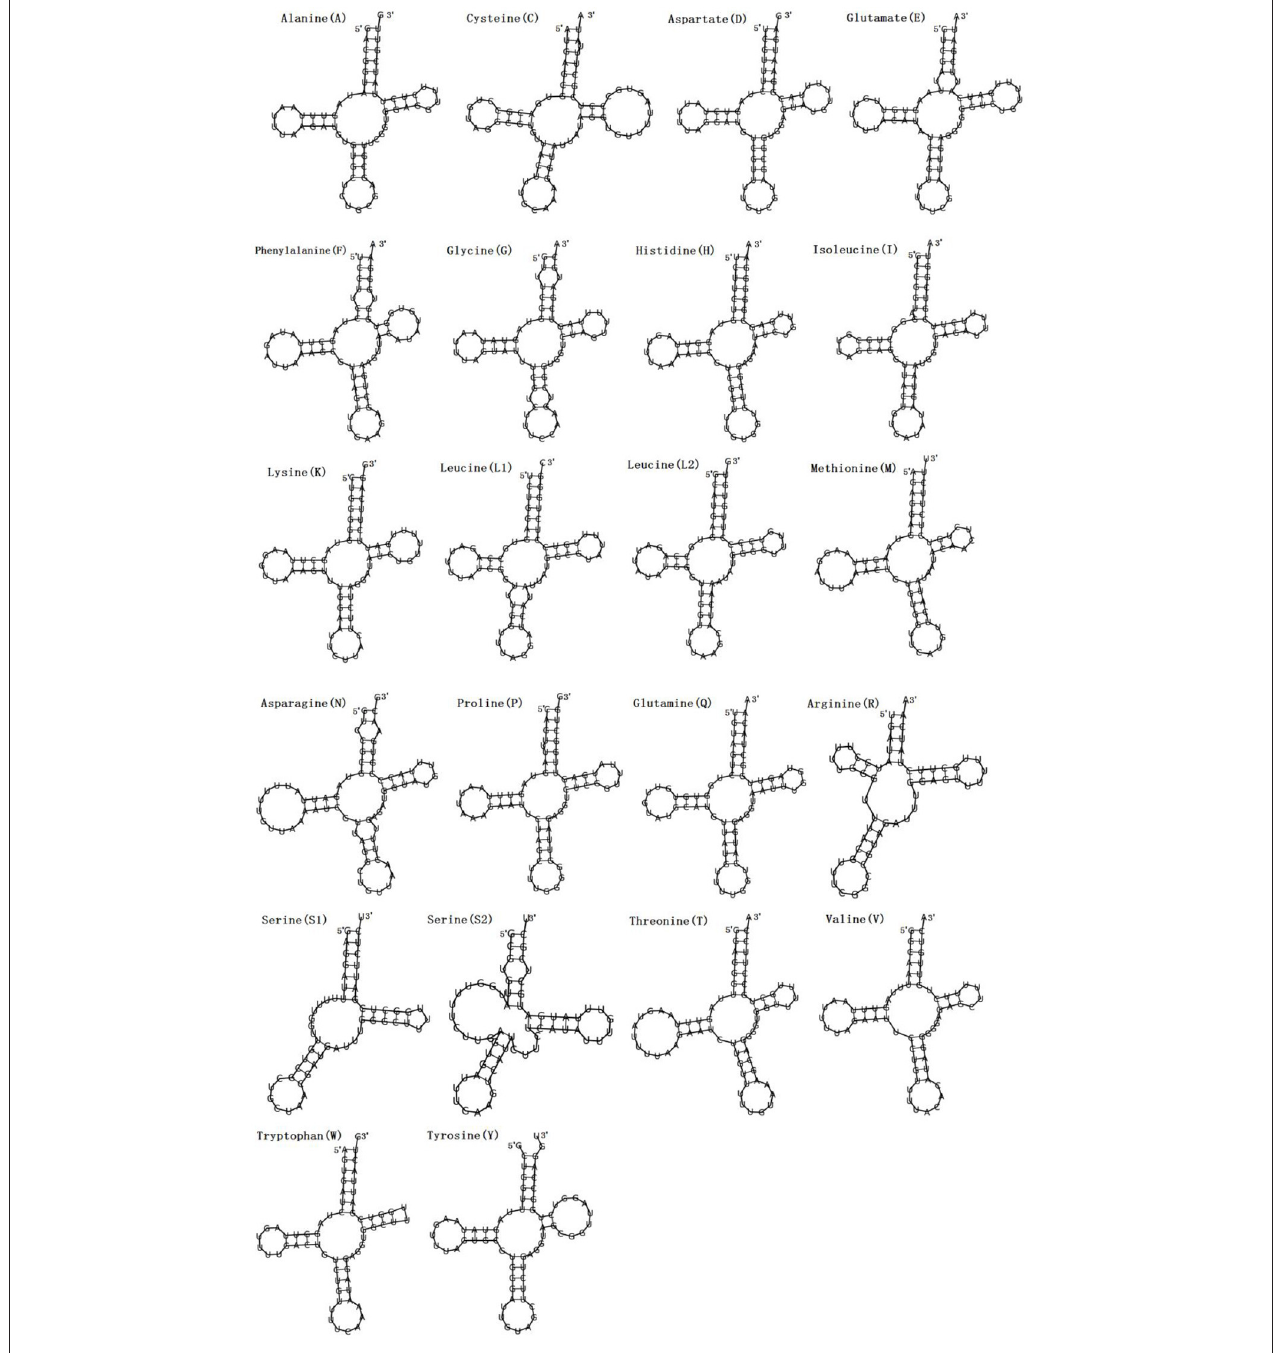
FIGURE 2 | Secondary structures of the 22 transfer RNA genes of F. intermediate tRNAs (labeled with the abbreviations of their corresponding amino acids).